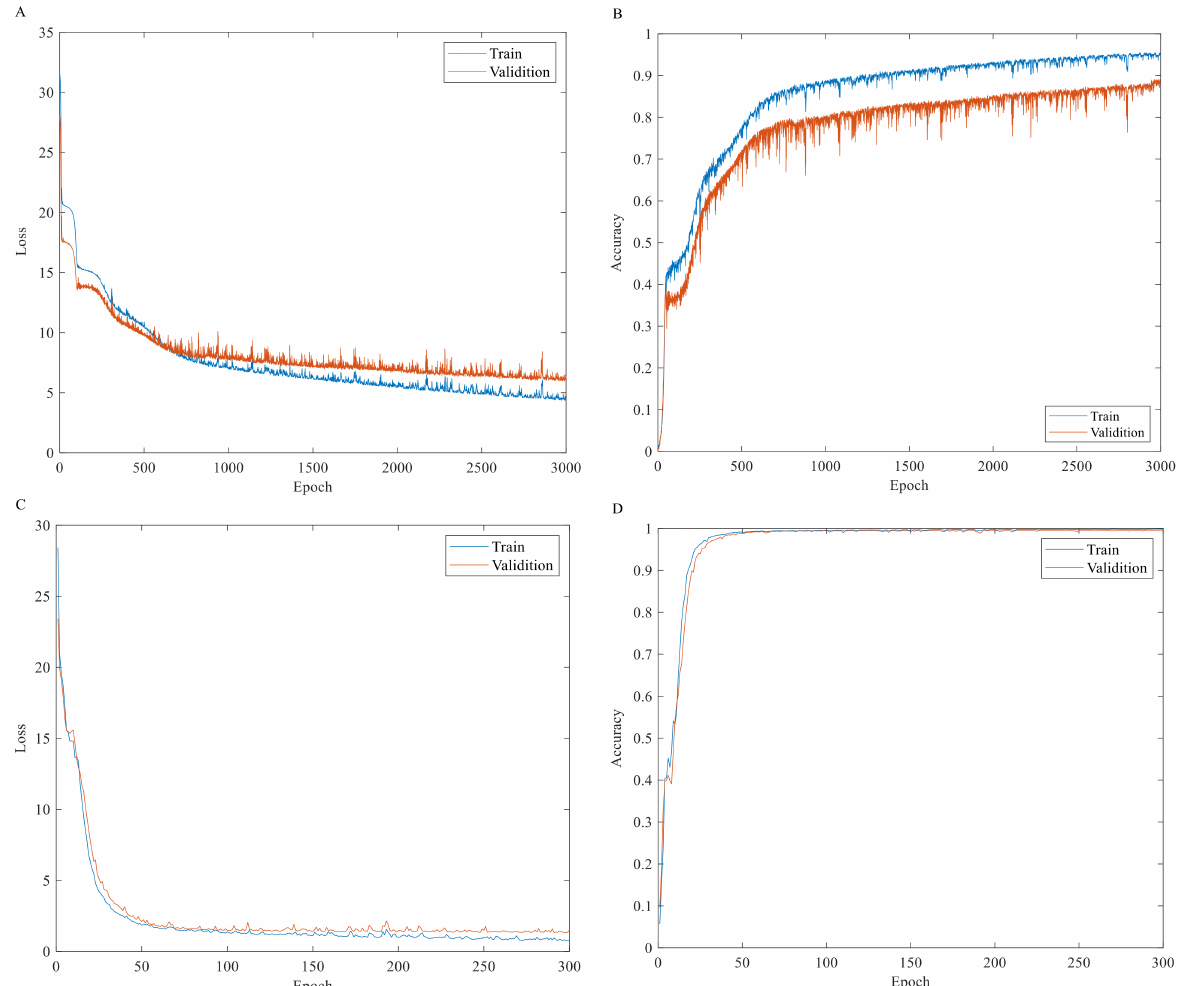
Figure 4. The training results of the convolutional neural network. ( A ) Loss of 1D-CNN; ( B ) Accuracy of 1D-CNN; ( C ) Loss of 2D-MTF-CNN; ( D ) Accuracy of